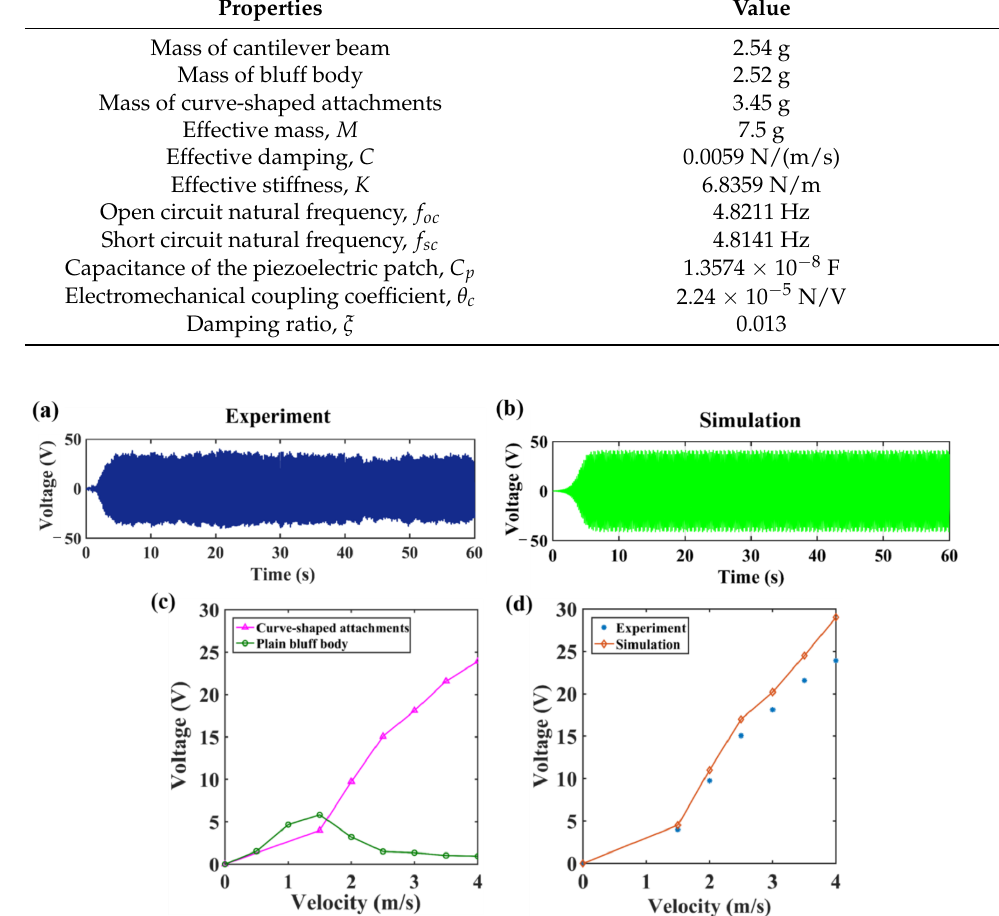
Figure 5. Experimental and simulation output voltage: ( a ) experiment at 4 m/s wind speed; ( b ) sim- ulation at 4 m/s wind speed; ( c ) experimental output voltage with and without attachments and ( d ) comparison at different wind